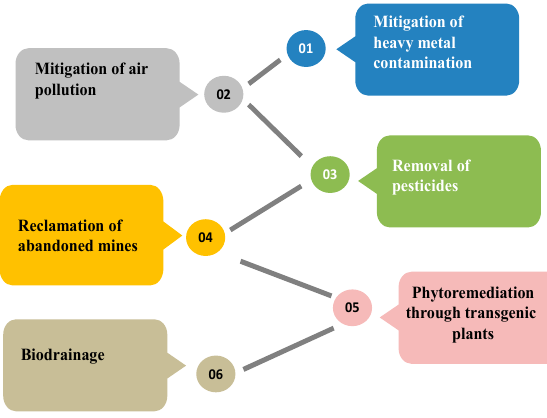
Figure 8. Phytoremediation applications.